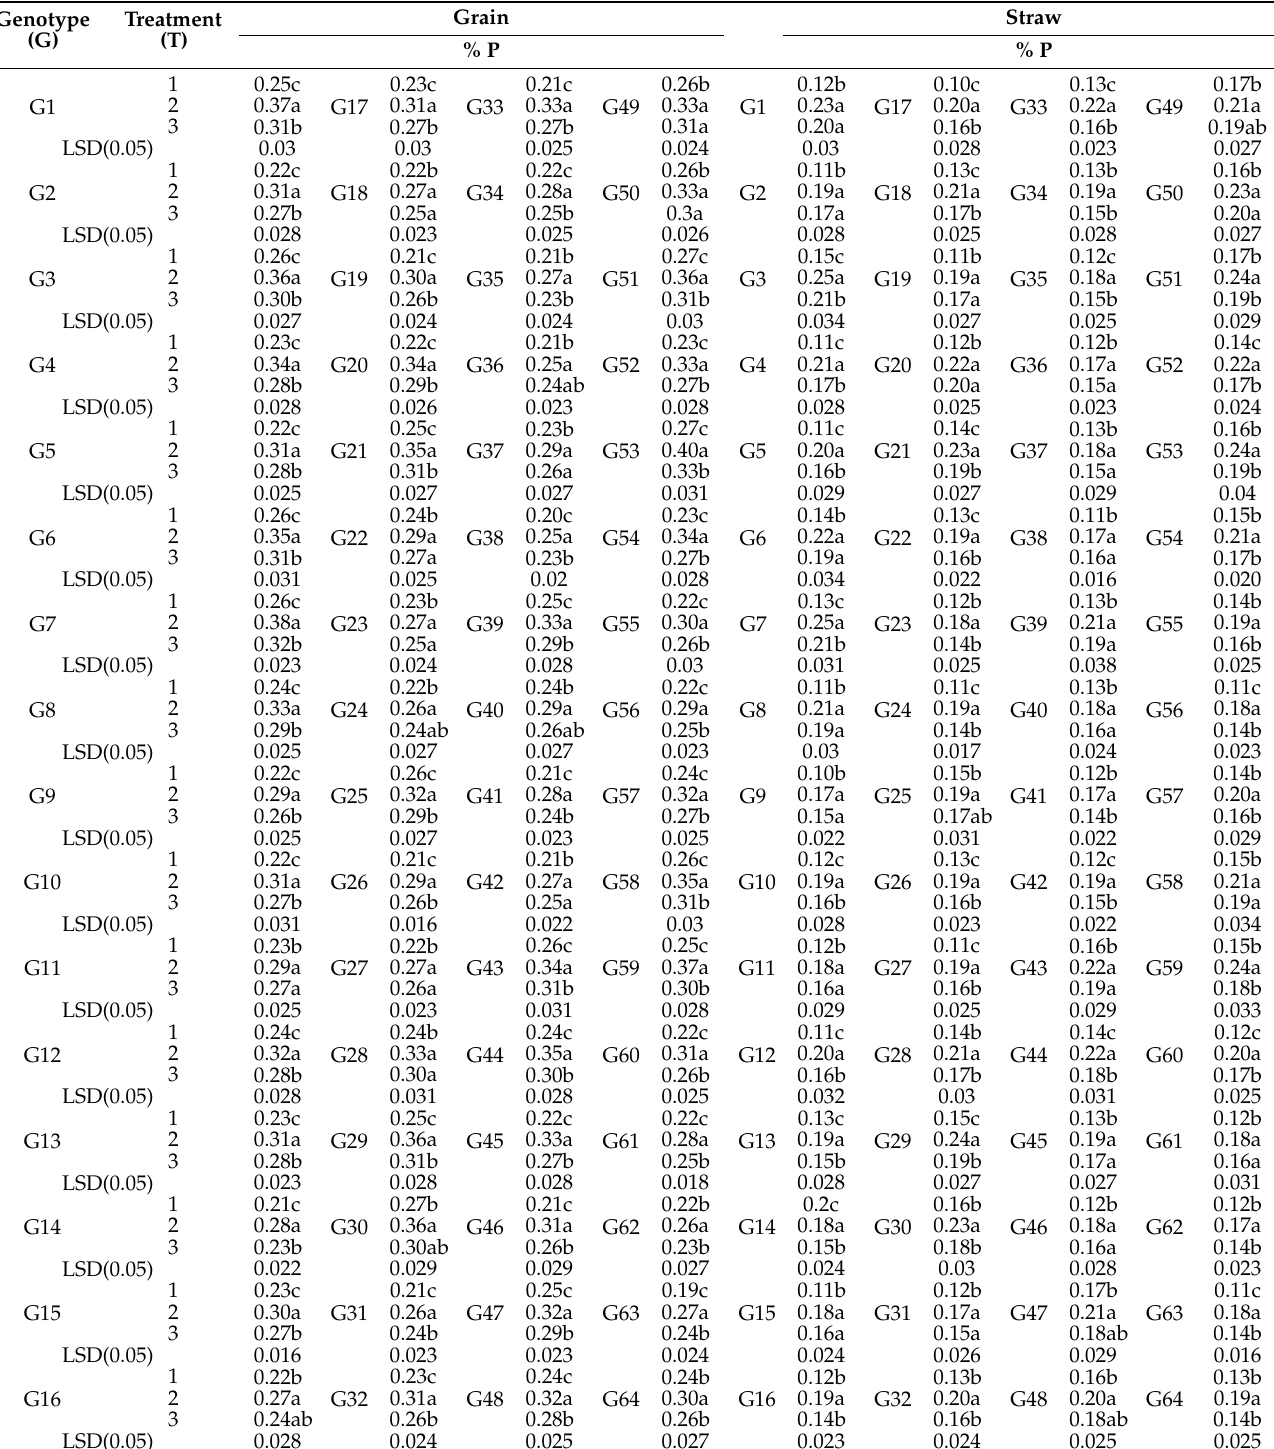
Table 11. Grain and straw nutrient content (% P) of 64 rice genotypes as influenced by treatment and genotype (pooled over two